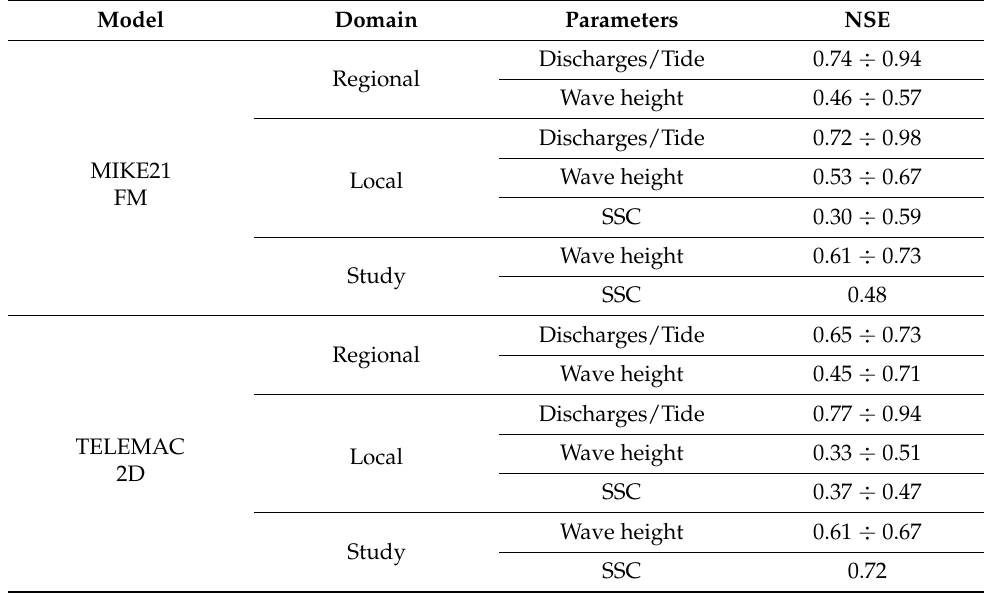
Table 2. Results of model